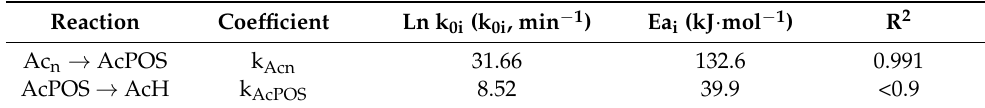
Table 7. Results calculated for the parameters governing the reactions of acetyl groups and acetic acid.